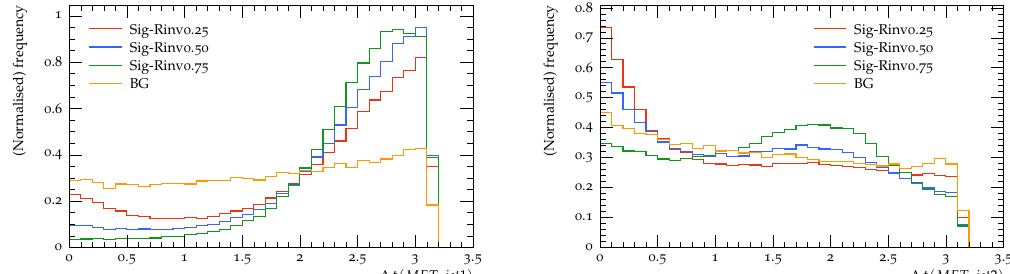
Figure 5: Distributions of the azimuthal angle difference between the leading (left) and subleading (right) jets with the direction of missing transverse momentum for three different signals corresponding to R values of 0.25, 0.50 and 0.75, and the inv background.